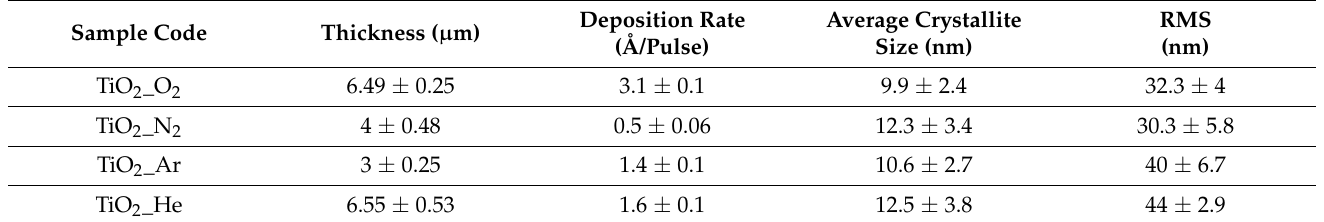
Table 2. Thicknesses, deposition rates, crystallinities by Scherrer equation, and roughness of TiO 2 thick nanostructured films grown under different gas